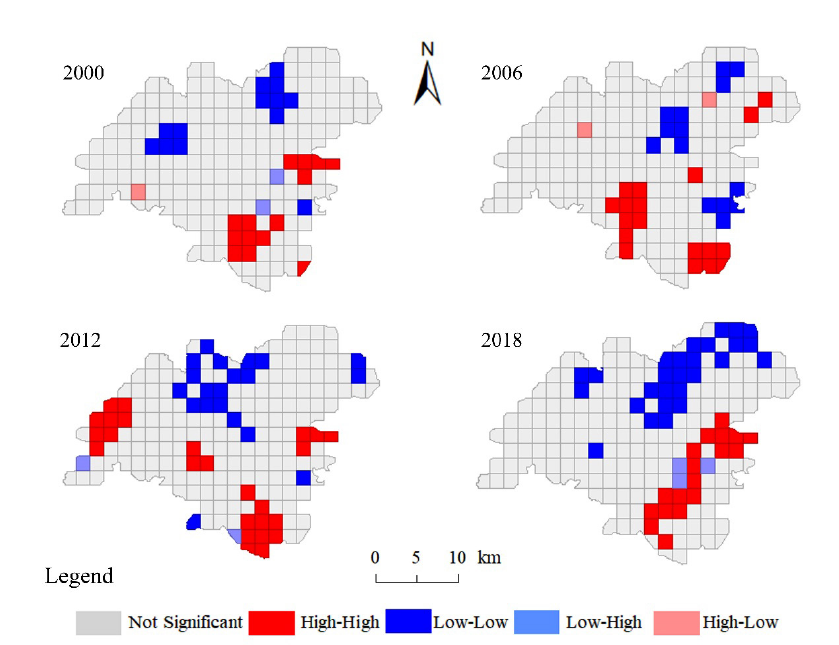
Figure 5. LISA cluster map of landscape ecological security in Zhong County from 2000 to 2018